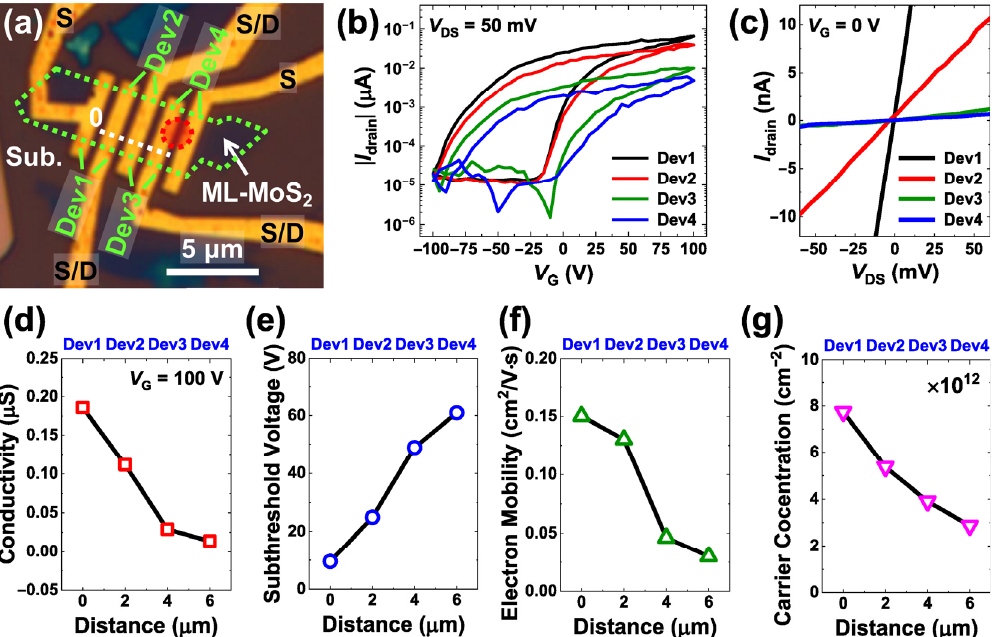
Figure 6. Variations in field-effect transistor (FET) characteristics of ML-MoS 2 -based FET devices by the area-selective FLI process: ( a ) An OM plan-view image of the four FET devices (Dev1–4) based on a single ML-MoS 2 flake. The red dashed circle indicates that the irradiation center was located inside the Dev4 channel. ( b ) The drain current vs. gate voltage ( I drain vs. V G ) curves measured from the devices at the drain-to-source voltage ( V DS ) of 50 mV. ( c ) The set of I drain vs. V DS plots of the four devices at V G = 0. From the I drain vs. V G data in ( b ), the following important device parameters and electronic properties of the ML-MoS 2 channels can be extracted: ( d ) channel conductivity ( σ ) at V G = 100 V, ( e ) subthreshold voltage ( V th ), ( f ) electron mobility ( µ ), and ( g ) electron carrier concentration ( n 2D ). The distance d in ( d – g ) indicates the locations of the Dev1–4 along the dashed line parallel to the channel length from the origin 0 in the center line of the Dev1 channel as described in ( a ). Note that in ( g ), the n 2D values should be multiplied by 10 12